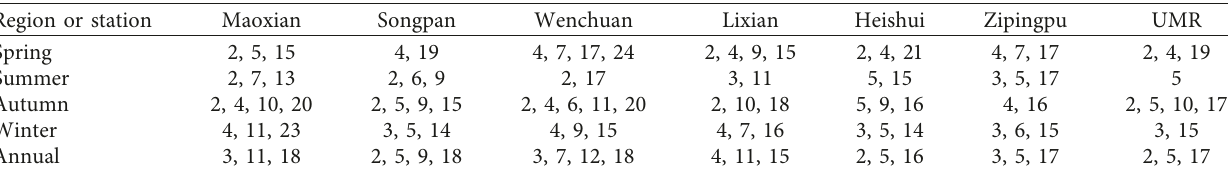
Table 5: Periods of precipitation time series.